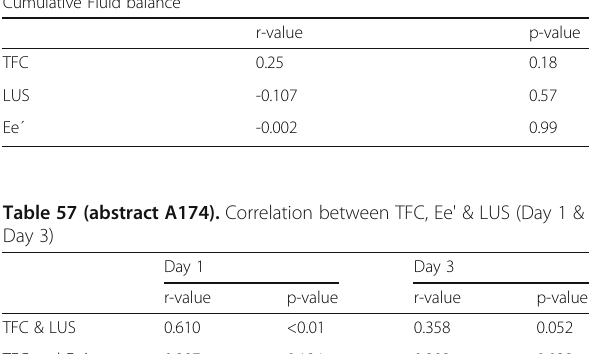
Table 56 (abstract A174). Correlation between CFB, TFC, Ee' (Day 3) Cumulative Fluid balance